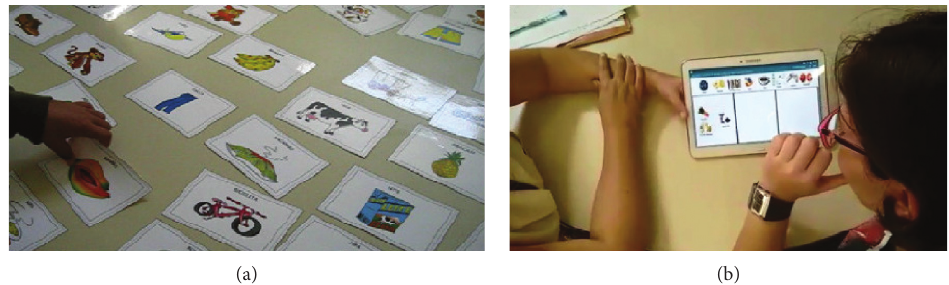
Figure 11: Traditional methodology (a) versus the new proposal (b).